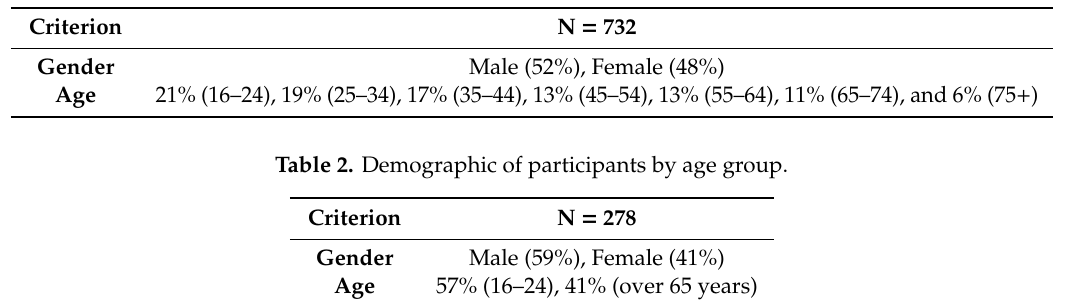
Table 1. Demographic of participants by gender group.